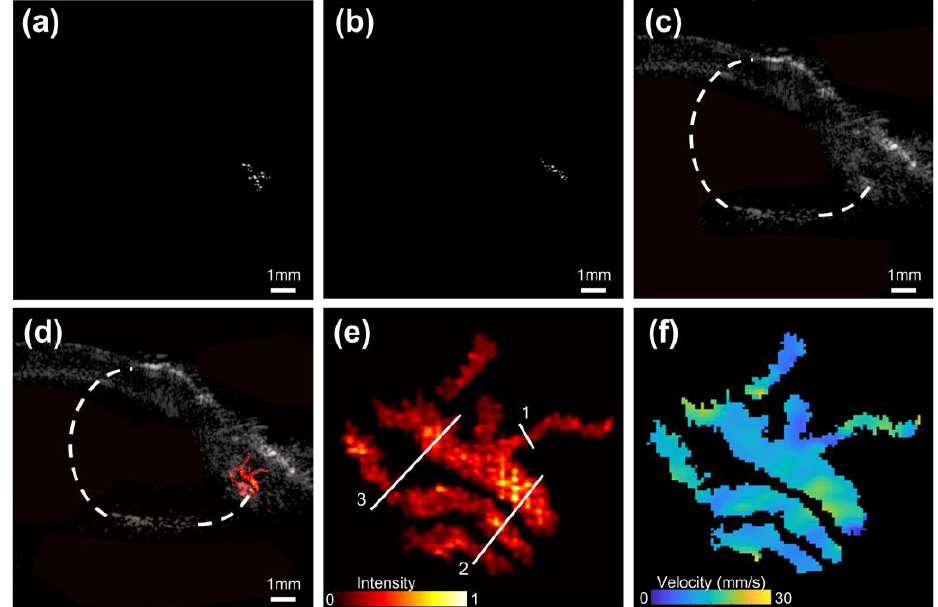
Figure 9. ( a , b ) Examples of the real-time US images after three-frame difference processing under different moments. ( c , d ) Examples of the real-time conventional B-mode image and its superimposed image with the reconstructed super-resolution microvessel image in vivo. Eyeball region is marked in white dotted lines. ( e , f ) Super-resolution microvessel density map and flow speed map inside OCM of SD rat. Three-line markers in ( e ) were used to calculate the detectable resolution and the resolved distance.